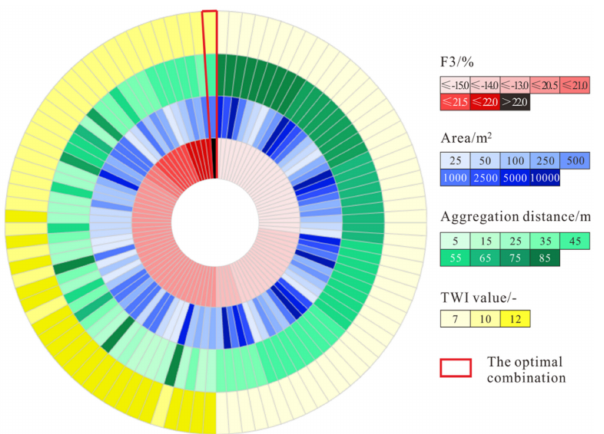
Figure 7. Selected representative options (i.e., top 50 and bottom 50 ranked according to the F3 values) out of the full set of combinations (i.e., 567